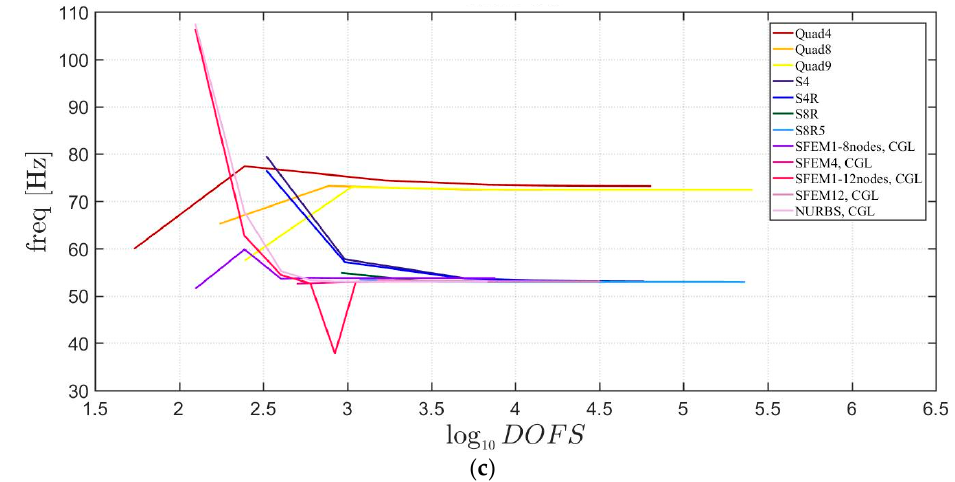
Figure 17. First three natural frequencies of a circular plate with a symmetric lamination scheme and a / h = 100: ( a ) First frequency; ( b ) Second frequency; ( c ) Third frequency.